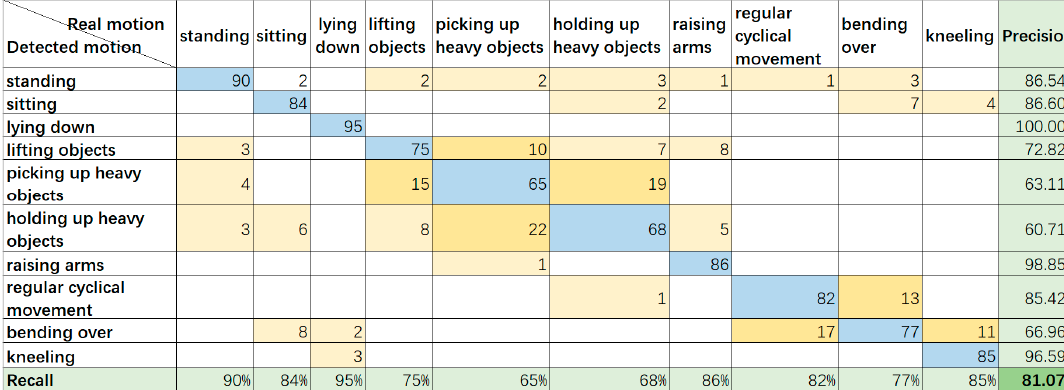
Figure 10. Simulation result for situation 2.